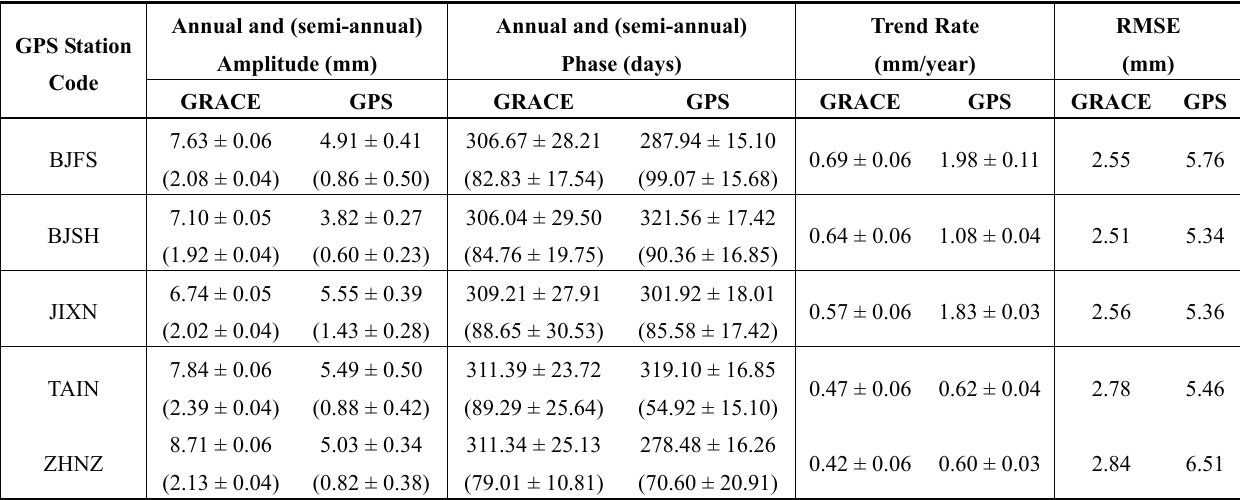
Table 2. Seasonal ( i.e. , annual and semi-annual) amplitudes and phases, trend fit of vertical displacements derived by GRACE and GPS for selected GPS stations, and their corresponding goodness-of-fit value in terms of Root-Mean Square Error (RMSE). Note that the semi-annual amplitudes and phases are listed in the corresponding